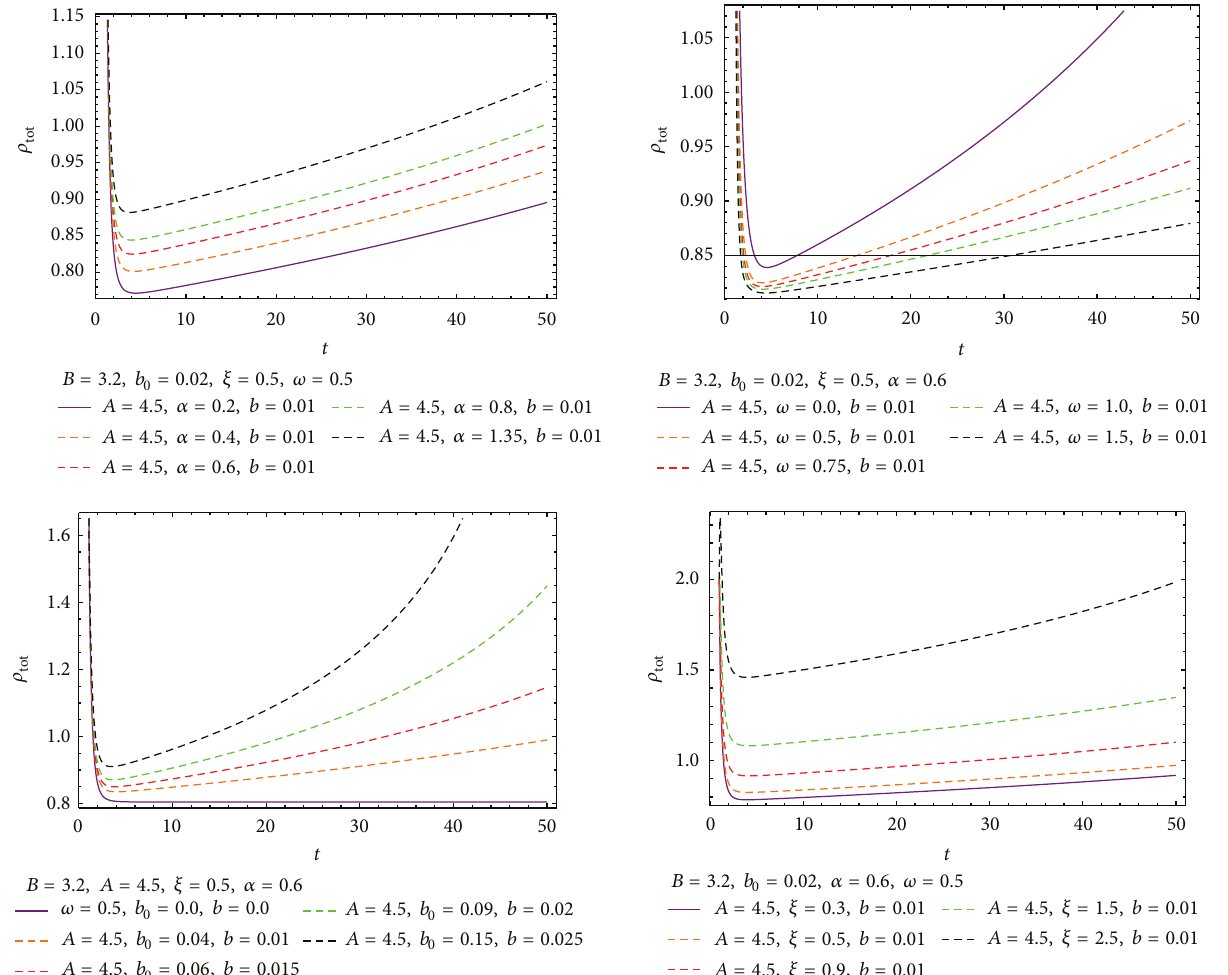
Figure 8: Behavior of 𝜌 against 𝑡 for interacting barotropic fluid and viscous Chaplygin tot